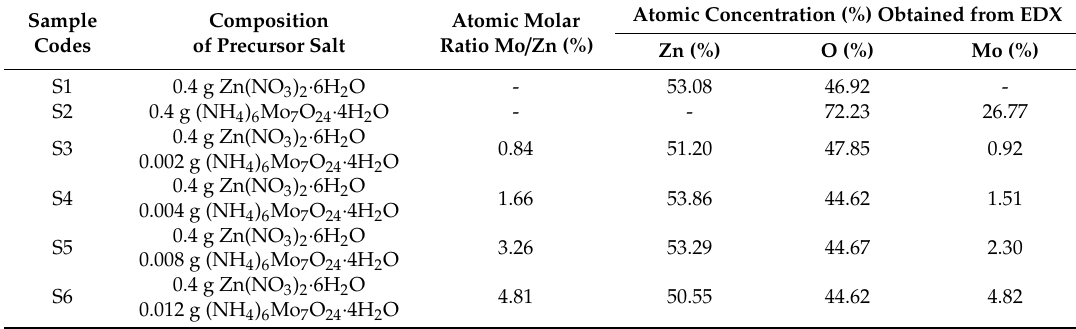
Table 1. Results of EDX (energy-dispersive X-ray spectroscopy) measurements for the pure ZnO, MoO 3 , and ZnO-incorporated MoO 3